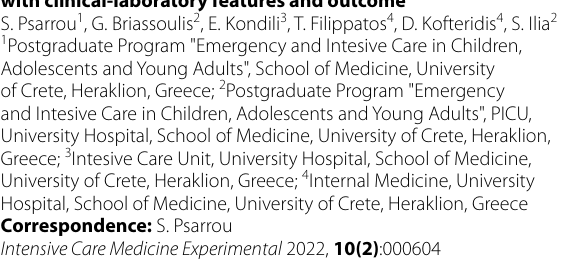
Figure 1. Prognostic factors for deterioration and ICU admission A. Clinical B.